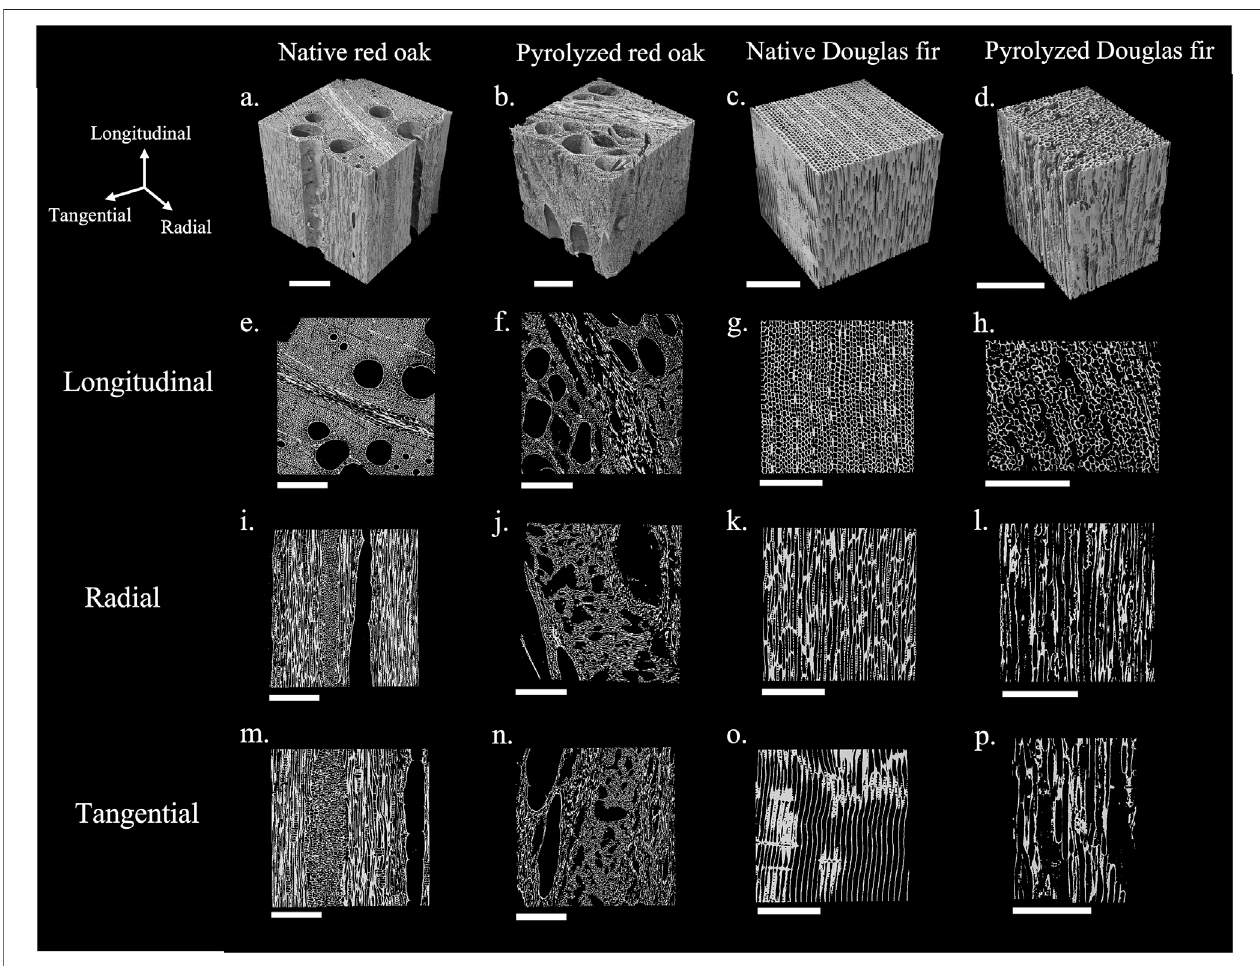
FIGURE 3 | Sub-volumes of each sample with longitudinal, radial, and tangential slices. (A) Native red oak sub-volume, (B) Pyrolyzed red oak sub-volume, (C) NativeDouglas fi rsub-volume, (D) PyrolyzedDouglas fi rsub-volume,Longitudinalslicesof (E) Nativeredoak, (F) Pyrolyzedredoak, (G) NativeDouglas fi r, (H) Pyrolyzed